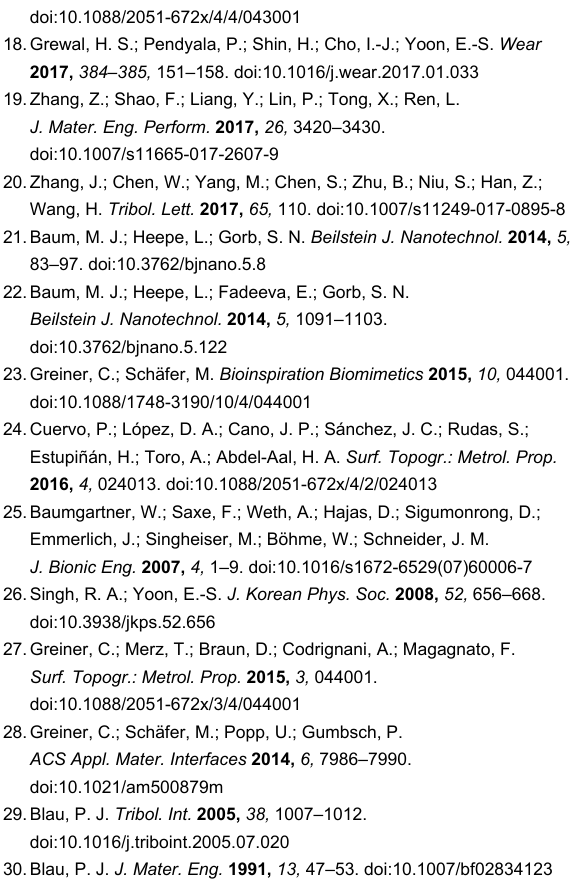
Figure S1: Optical micrograph of a scale-like surface texture after 1000 m of dry sliding against sapphire. Figure S2: Scanning electron microscopy image of a focused ion beam cross-section of a laser-textured sample. Figure S3: Optical micrograph of a PEEK disc after a dry sliding